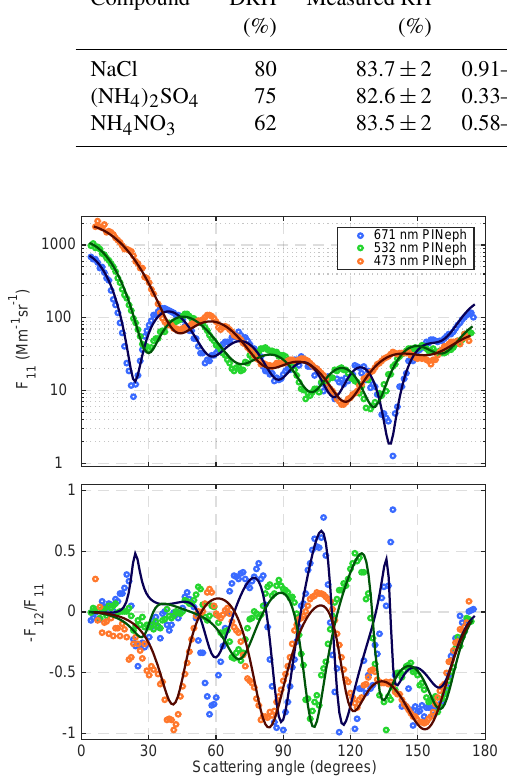
Figure 8. Scattering matrix elements at 473nm (blue), 532nm (green) and 671nm (red) for 903nm diameter PSL sample along with the corresponding GRASP fits (solid